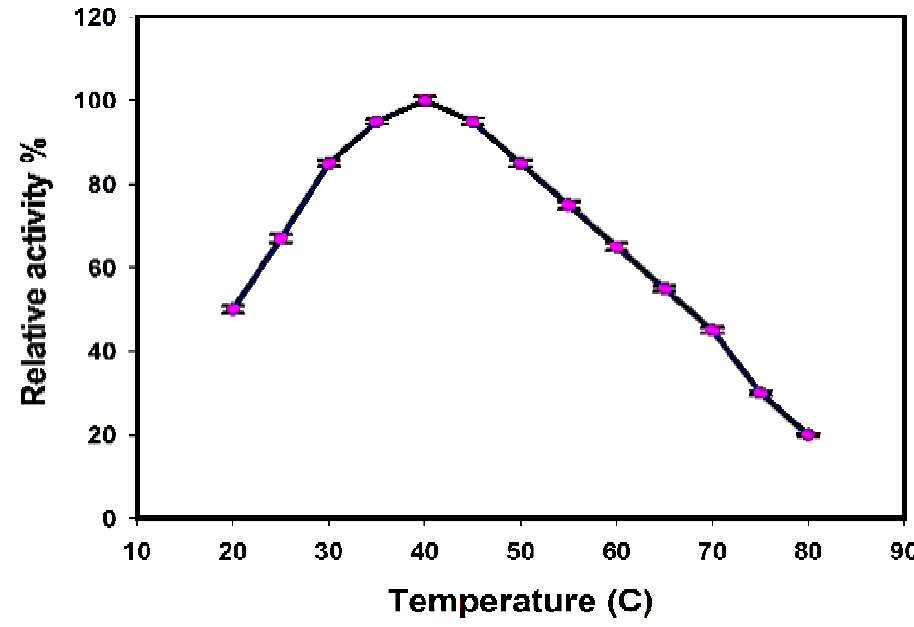
Figure 8. Temperature stability of purified xylanase.